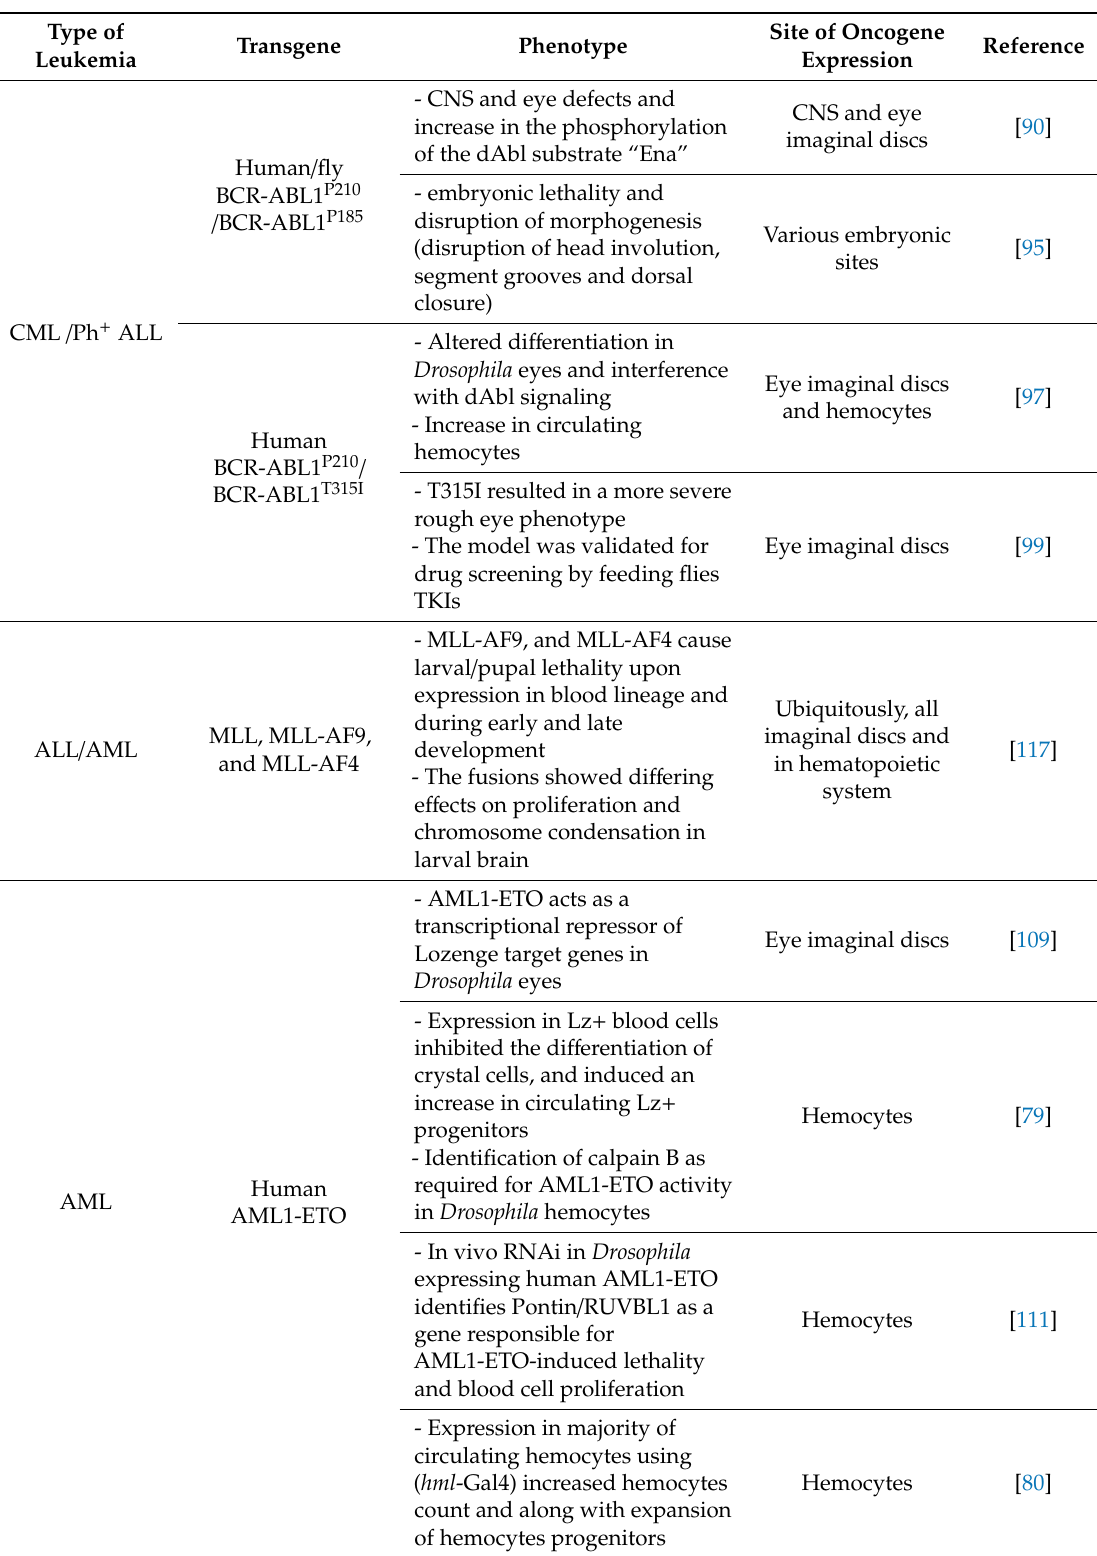
Table 1. Summary of human leukemia models in Drosophila melanogaster. This table summarizes the studies that used Drosophila melanogaster for modeling human leukemogenic proteins in hematopoietic and non-hematopoietic tissues and their major